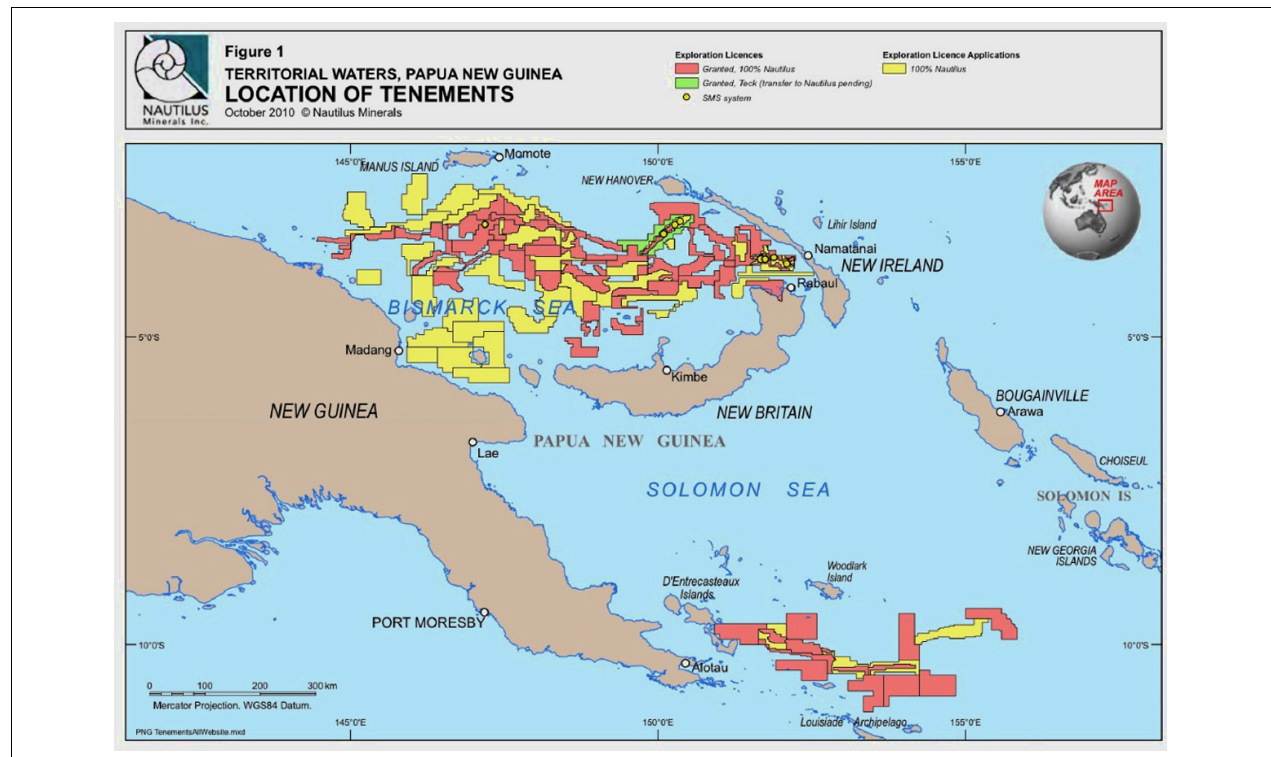
FIGURE 5 | Solwara 1 project is the first proposed DSM area for PNG. Nautilus Tenements in PNG